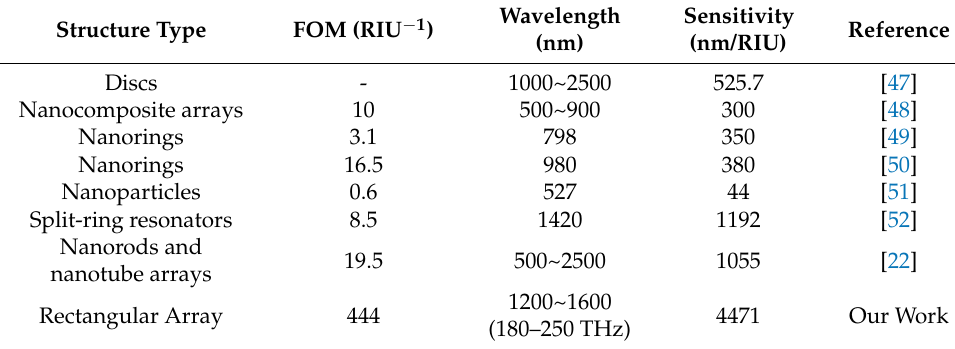
Table 2. Comparison of the proposed structure with the already existing